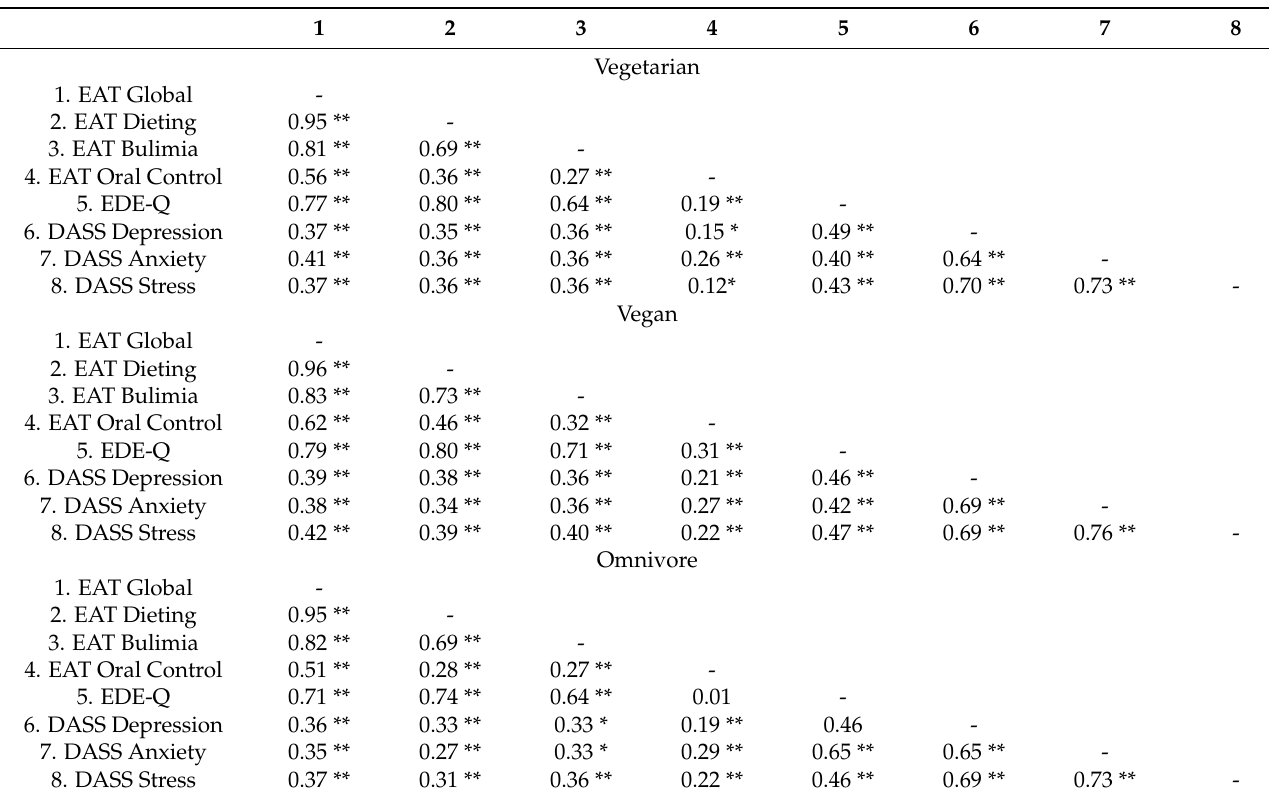
Table 4. Convergent and discriminant validity of the Eating Attitudes Test in vegetarians, vegans, and omnivores.